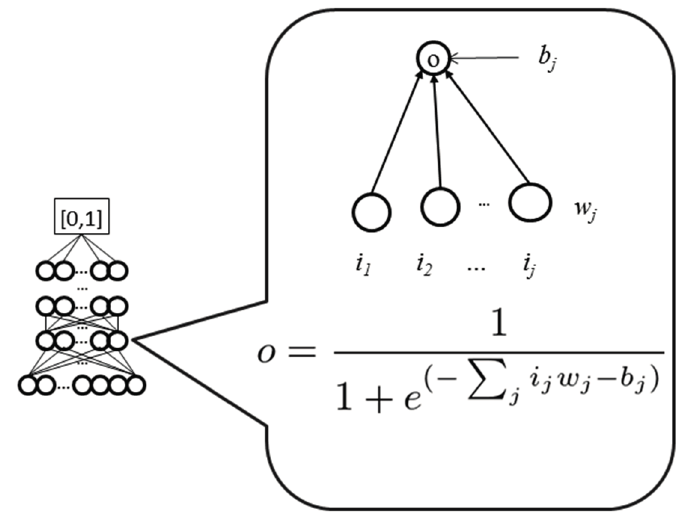
Figure 3. Graphical representation of a neural